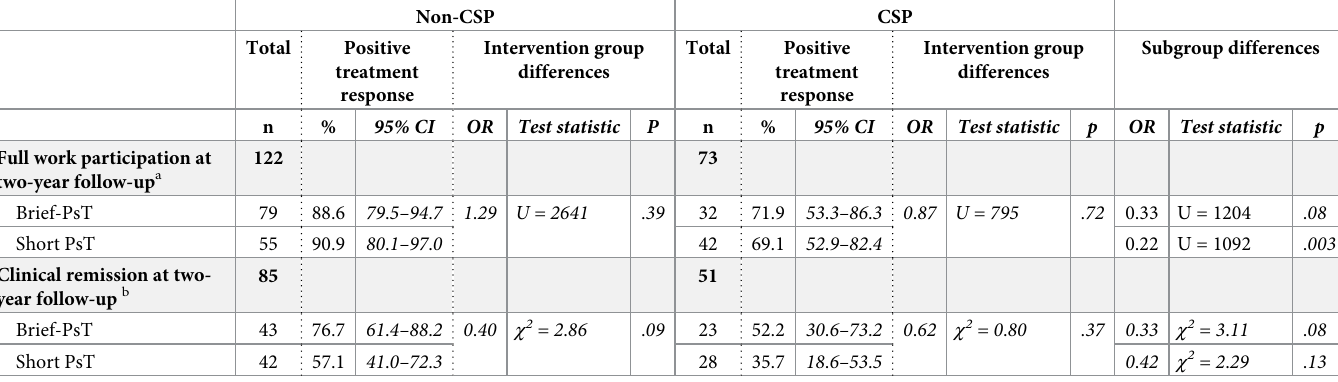
Table 7. Full work participation and clinical remission rate at two-year follow-up, stratified for the presence of CSP and intervention